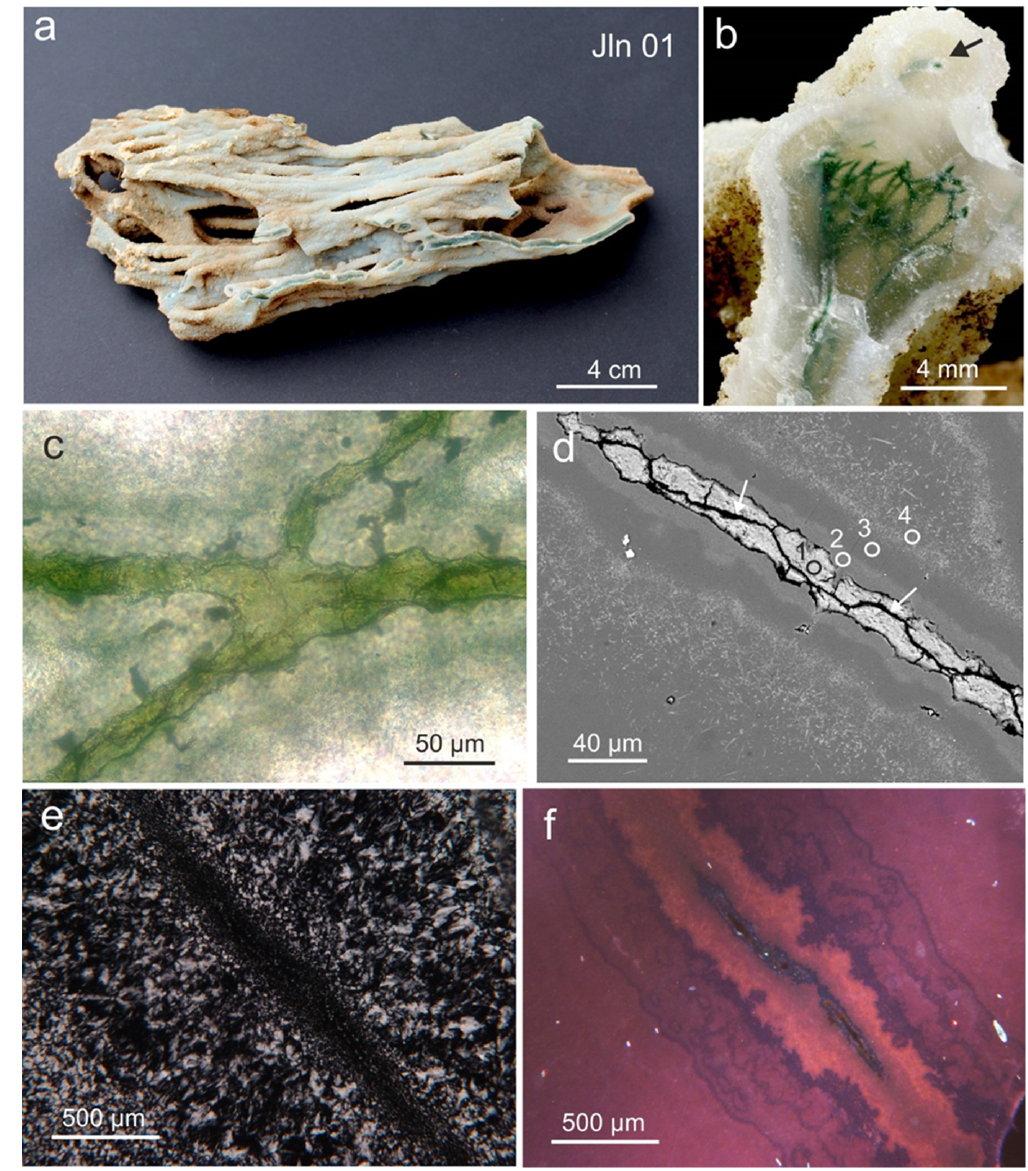
Figure 18. Images and micrographs showing the characteristic texture of sample Jln 01 (Jalna): ( a ) chalcedony aggregate consisting of a network of elongated, intergrown filamentous structures; ( b ) cross-section of an filamentous aggregate showing several green filamentous structures embedded in clear silica; the arrow points to the concentric structure surrounding the filamentous core; ( c ) transmitted light micrograph showing the internal structure of the filamentous core revealing a thin, dark green strand consisting of celadonite embedded in silica; ( d ) SEM-BSE image of the filamentous core; the numbers relate to measuring points of SEM-EDX analyses (for data see Table S7); the dark line in the center (see arrows) marks an empty space, which probably resulted from the former innermost filamentous core; ( e , f ) micrographs in transmitted light (crossed polars (e)) and CL ( f ) showing the non-luminescent core and di ff erent SiO 2 layers with varying luminescence colors. Details of the structure show a netlike intergrowth of green filaments within a transparent silica matrix. A thin, dark filamentous core measuring ca. 10 µ m is visible within the intergrown filaments (Figure 18c). SEM investigations at high magnification revealed a zoned structure of the green filamentous cores (Figure 18d). The chemical composition of the di ff erent zones